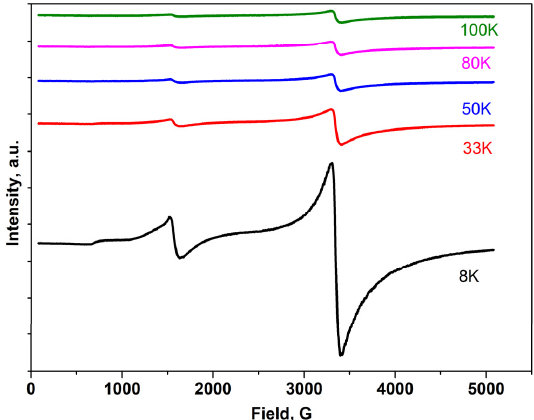
Figure 12. EPR spectra of sample FA-S2-1-300 in the range from 8 to 100 K. One line corresponds to a g-factor of 4.3; two other lines of different widths correspond to signals with a g-factor close to 2. An example of such a decomposition is shown in Figure 13.